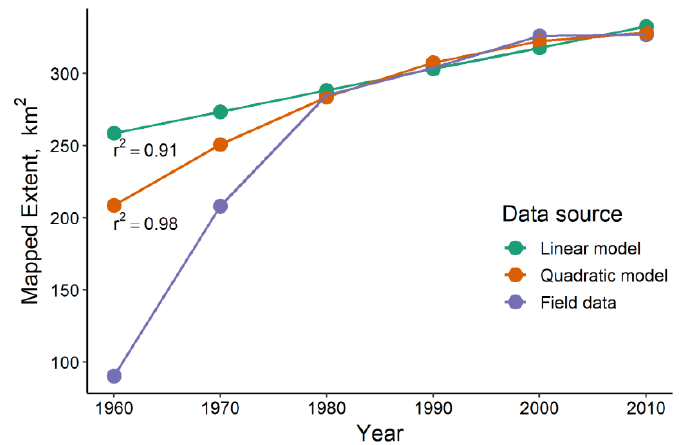
Figure 7. Three methods for quantifying how the maximum extent of fishing changed over time (1960–2010). The field data estimated a sharp increase in the spatial extent of fishing over time. In contrast, linear and quadratic models (built excluding years with small numbers of actively fishing respondents) showed a relatively smaller increase in the maximum extent of fishing grounds. There was no significant difference between the fit of linear and quadratic models.